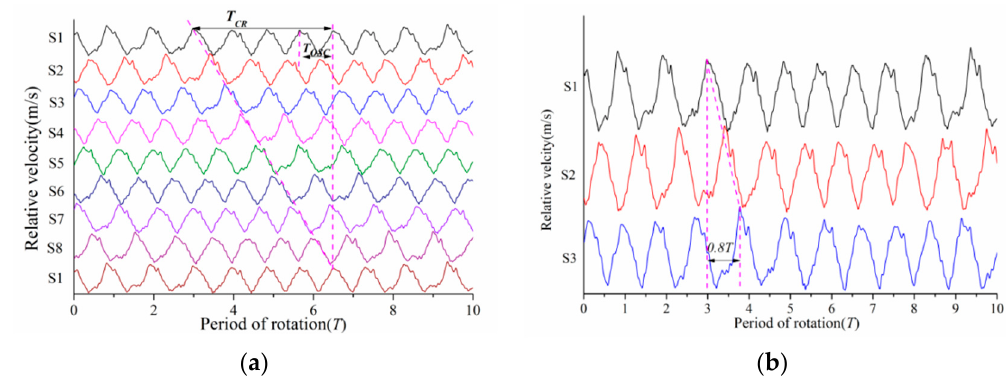
Figure 10. Relative velocity curve of the monitoring point when the flowrate is 0.8 kg/s: ( a ) the curve of the relative velocity at 8 points; ( b ) the curve of the relative velocity at 3 adjacent points.